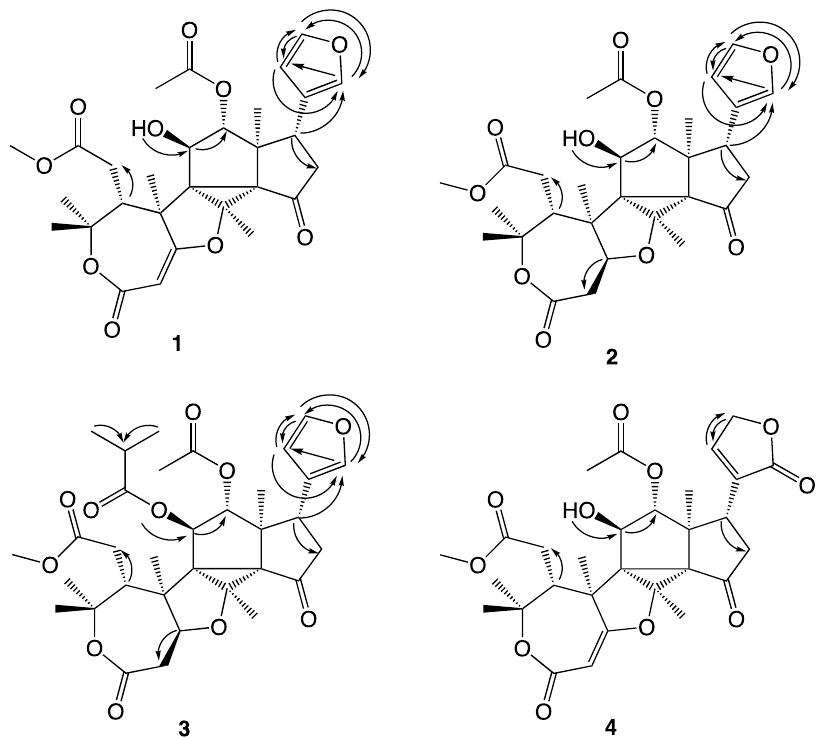
Figure 3. COSY correlations observed with compounds 1 – 4 .